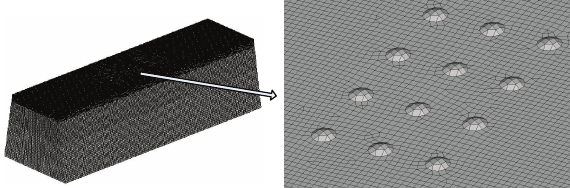
Figure 8: The mesh and enlarged view profile.